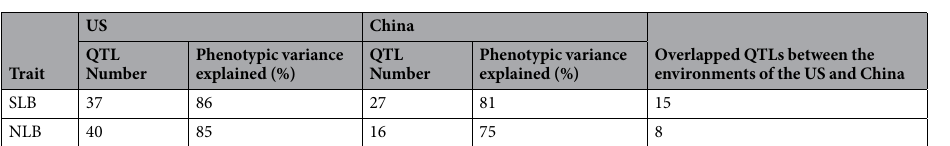
the confidence intervals of DTA QTLs. Moreover, six regions associated with all three traits examined were iden- tified (Supplementary Table S2). Co-localization test between resistance-implicated genes and identified QTLs. Based on a liter- ature search, a set of 245 resistance-implicated genes (Supplementary Dataset S2), including NB-LRR type genes from previous publications 29,30 , the identified SLB and NLB R-genes 4,6,28 and disease resistance homologues in MaizeGDB (http://www.maizegdb.org/) determined through genome sequence analysis, were selected to conduct the co-localization test. We observed 54 and 25 resistance-implicated genes within the SLB and NLB resistance QTLs, respectively. Significant co-localization was observed for SLB ( P = 0.0078), and not for NLB, resistance-related unique QTLs (Fig. 3). We identified four SLB resistance QTLs clustering with at least five resistance-implicated genes (mainly NB-LRR genes) in each region (Supplementary Fig. S2). Two of these QTLs were located in bins 4.01 (12